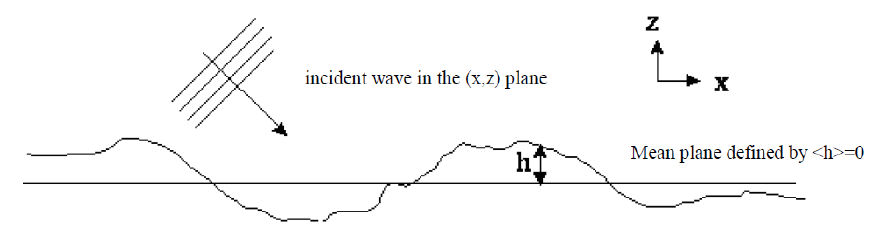
Figure 2. Variations of heights around an average